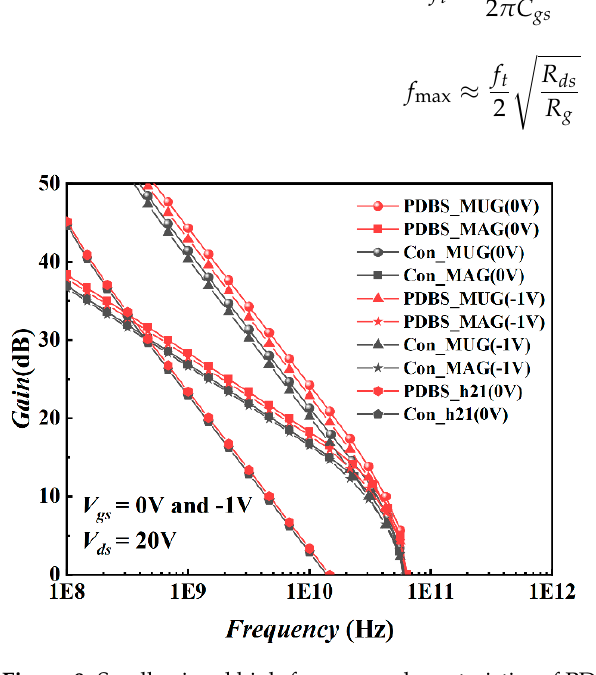
Figure 9. Small − signal high-frequency characteristics of PDBS − HEMT and Con − HEMT. Table 1. Parameters of the PDBS-HEMT and Con-HEMT. Table 1. Parameters of the PDBS-HEMT and Con-HEMT. Parameters